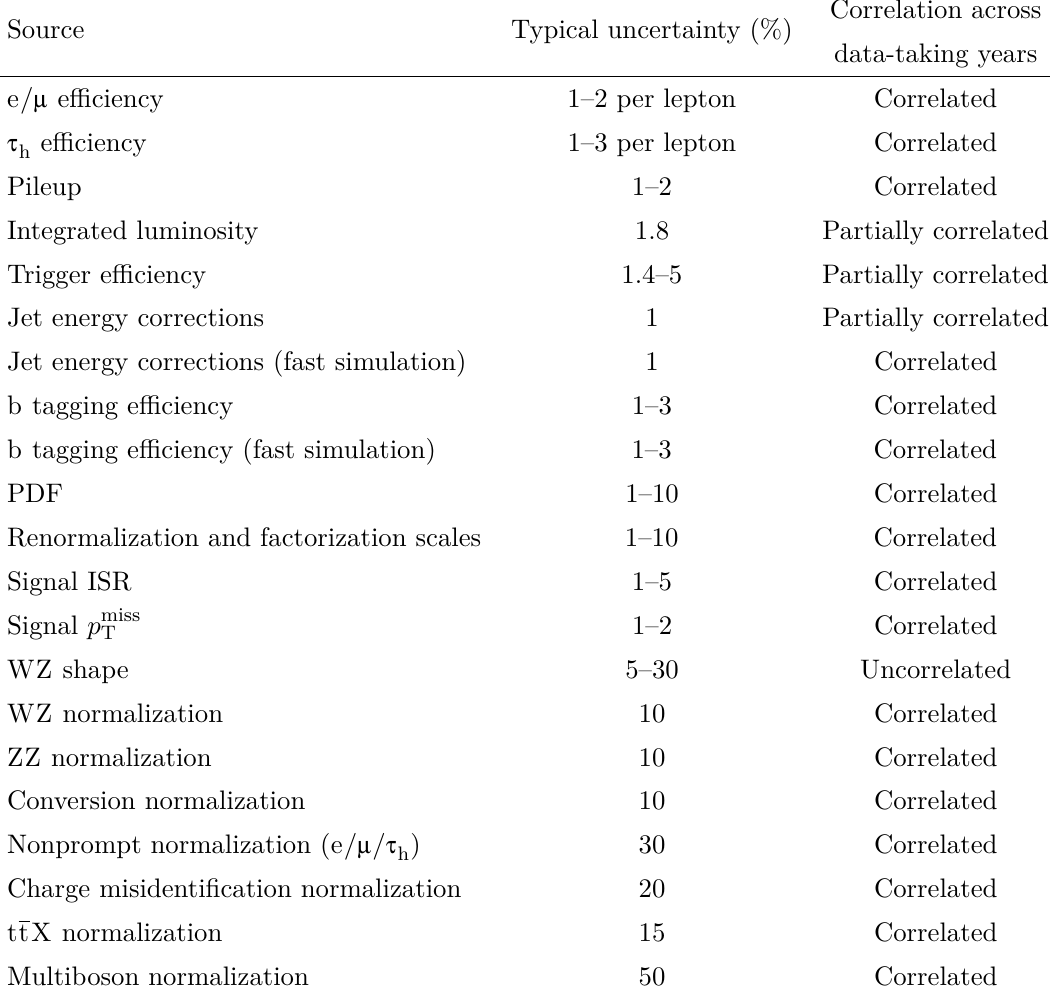
Table 12 . Systematic uncertainty sources affecting the analysis, with their typical size across signal regions, and the treatment of the correlations across data-taking years. Uncertainties in the jet energy corrections and b tagging efficiencies are considered separately for signal events which use CMS fast simulation, as explained in section 5, and for the other simulated processes. Both the overall integrated luminosity and all normalization uncertainties have effects on the predicted yields of the corresponding processes that are of the same size across all signal regions. Their quoted typical size corresponds to the size of such variations. All other uncertainties can have different effects on the predicted yields for each process and signal region. Their typical uncertainty corresponds to the range of sizes that such effects take across the analysis search